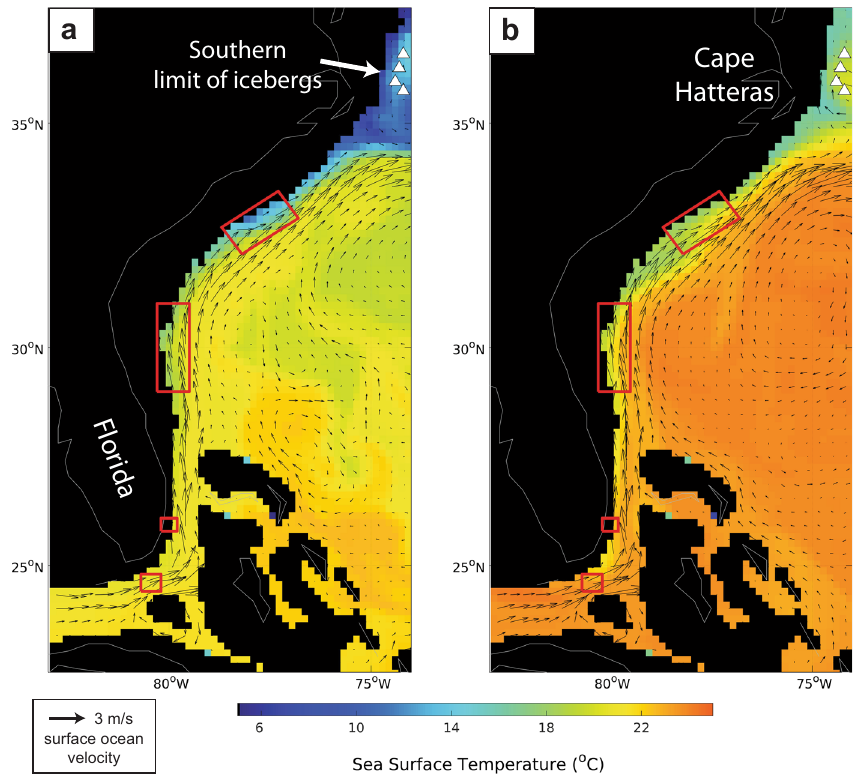
Fig. 2 Simulated glacial sea surface temperature and surface ocean velocity. The plots are drawn for January ( a ) and September ( b ) to show that the relict iceberg scours are located beneath the northward fl owing Gulf Stream where ocean temperatures in our glacial ocean circulation model simulations are >20 °C. White triangles above 35°N represent the maximum southerly location that icebergs are able to drift to in our control simulations (i.e., no meltwater forcing) and highlight that icebergs do not freely drift to the scour sites in the absence of meltwater currents. Black arrows denote the strength and direction of the surface ocean fl